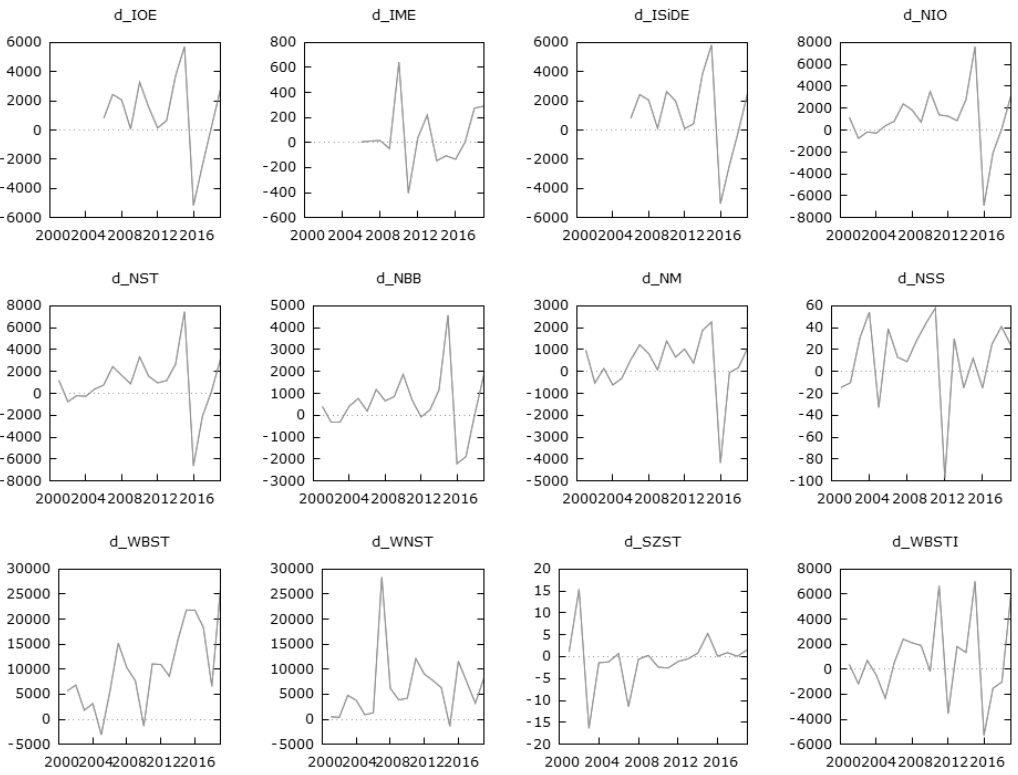
Figure A1. Stationary variables from Groups A and B. Source: Authors’ study.